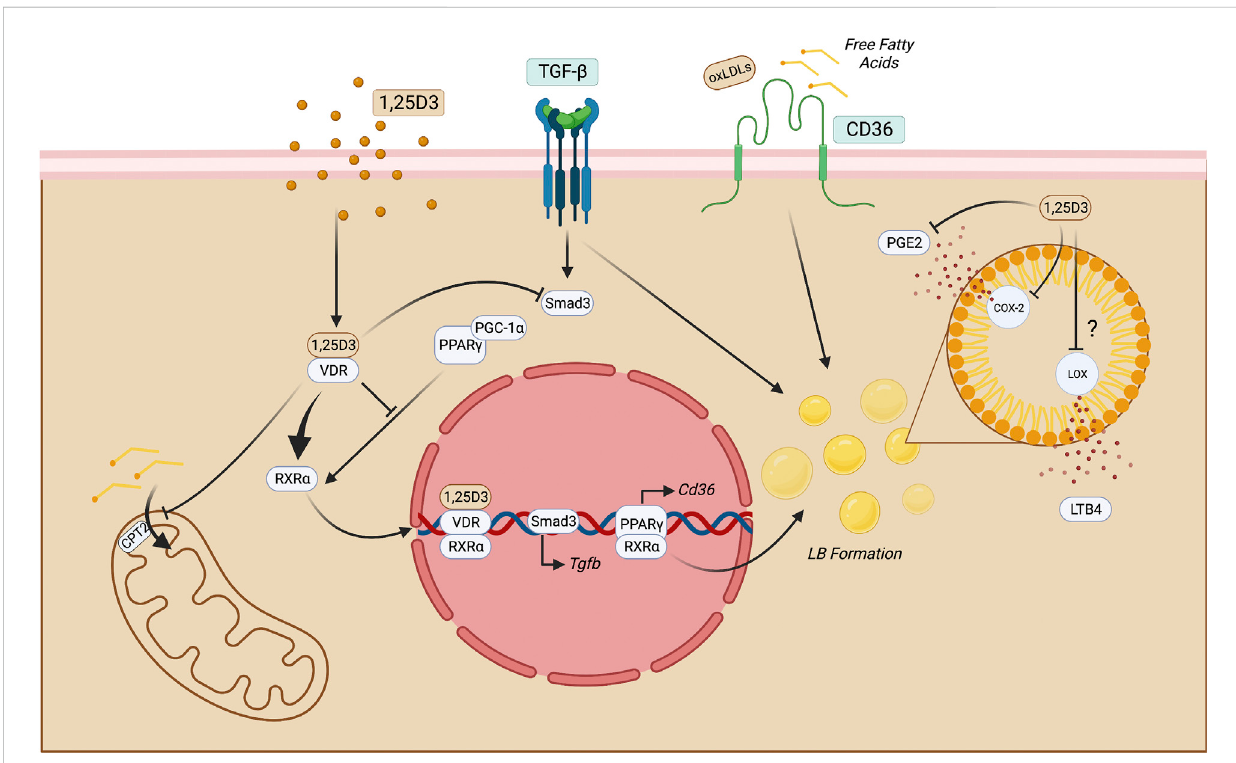
Putative mechanisms of 1,25D3 function in macrophages. Once 1,25D3 binds to VDR, it heterodimerizes with RXR α and translocate to the nucleus, impairing PPAR γ -mediated functions. This may impact LB formation and, therefore, reduce the production of eicosanoids, such as LTB4 and PGE2. The latter may also be reduced through direct inhibition of COX-2 through 1,25D3. PPAR γ blockade also may reduce CD36 exposure on the cell surface, leading to decreased lipid uptake. In macrophages, this process may limit FAO by inhibiting CPT2 and consequent long-chain fatty acid transport into the mitochondria. Moreover, since the fi brotic milieu is enriched with TGF- β , its signaling triggers Smad-3 and lipid accumulation in macrophages suggesting that this cytokine may have roles beyond fi brosis induction. 1,25 dihydroxyvitamin D3; COX-2, cicloxygenase-2; LOX, lipoxygenase; CPT, carnitinepalmitoyltransferase;FAO,fattyacidoxidation;LB,lipidbodies;LTB4,leukotrieneB4;PGE2,ProstaglandinE2;TECs,tubularepithelialcells;VDR, vitamin D receptor. Figure created with